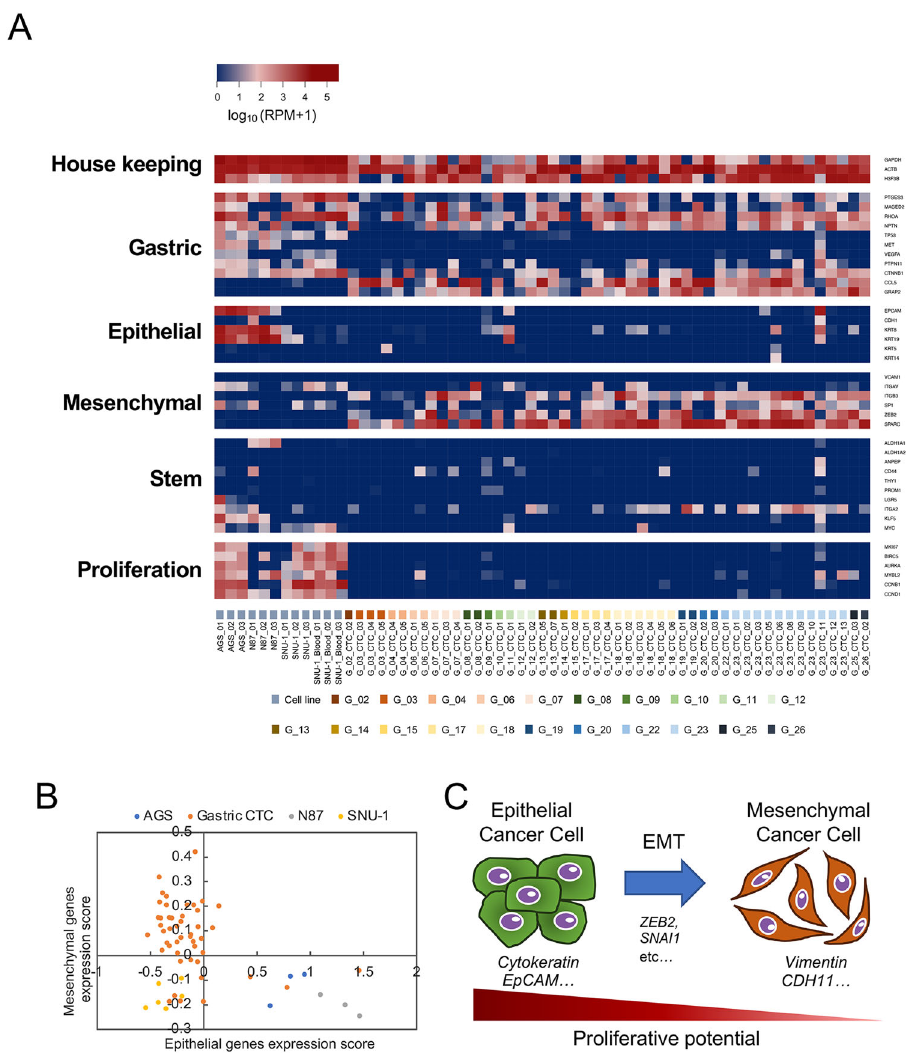
Fig. 3 Targeted analysis of single-cell RNA-seq data. A The heat map shows expression of housekeeping genes, gastric, epithelial, epithelial, stem cell, and proliferation markers. Scale in log10 (RPM + 1). Expression level increases from blue to red. B Scatter plots based on the expression levels of epithelial and mesenchymal genes. C Schematic of EMT induction and proliferative potential of cancer